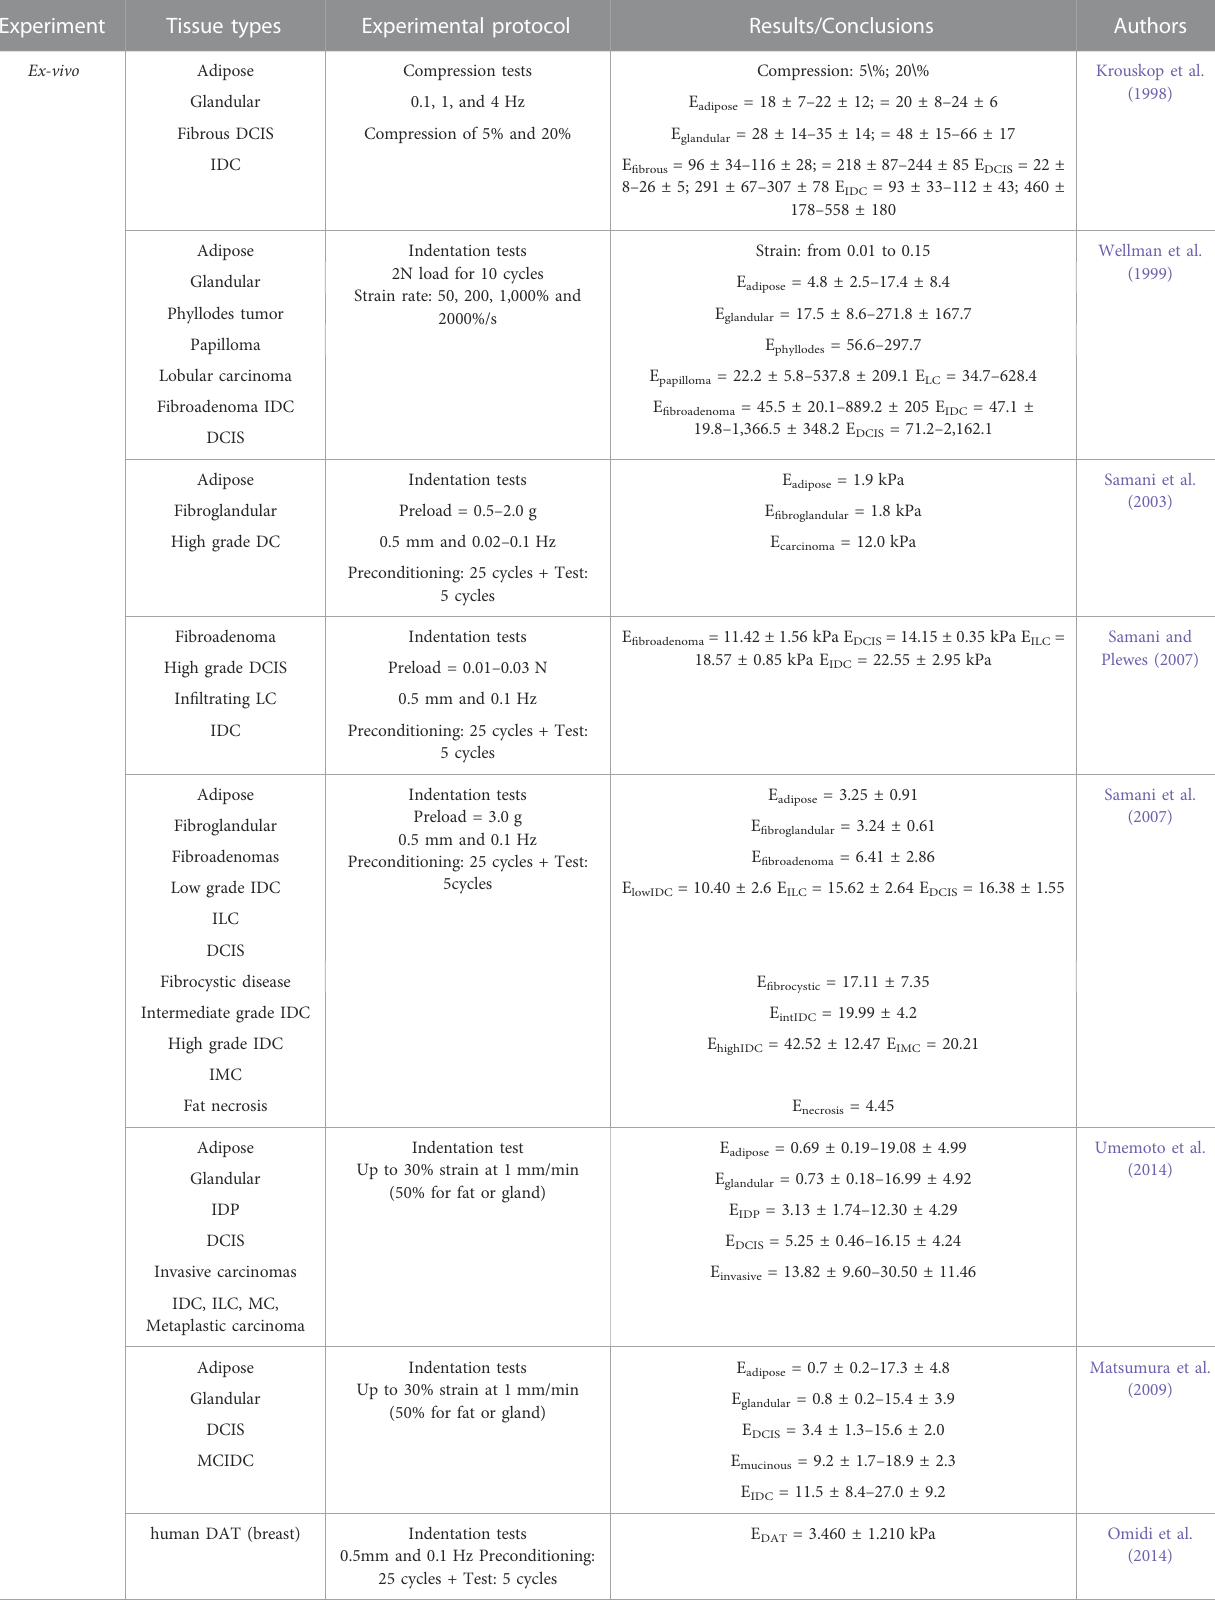
TABLE 2 Ex-vivo results of the elastic properties of breast tissues, reported in